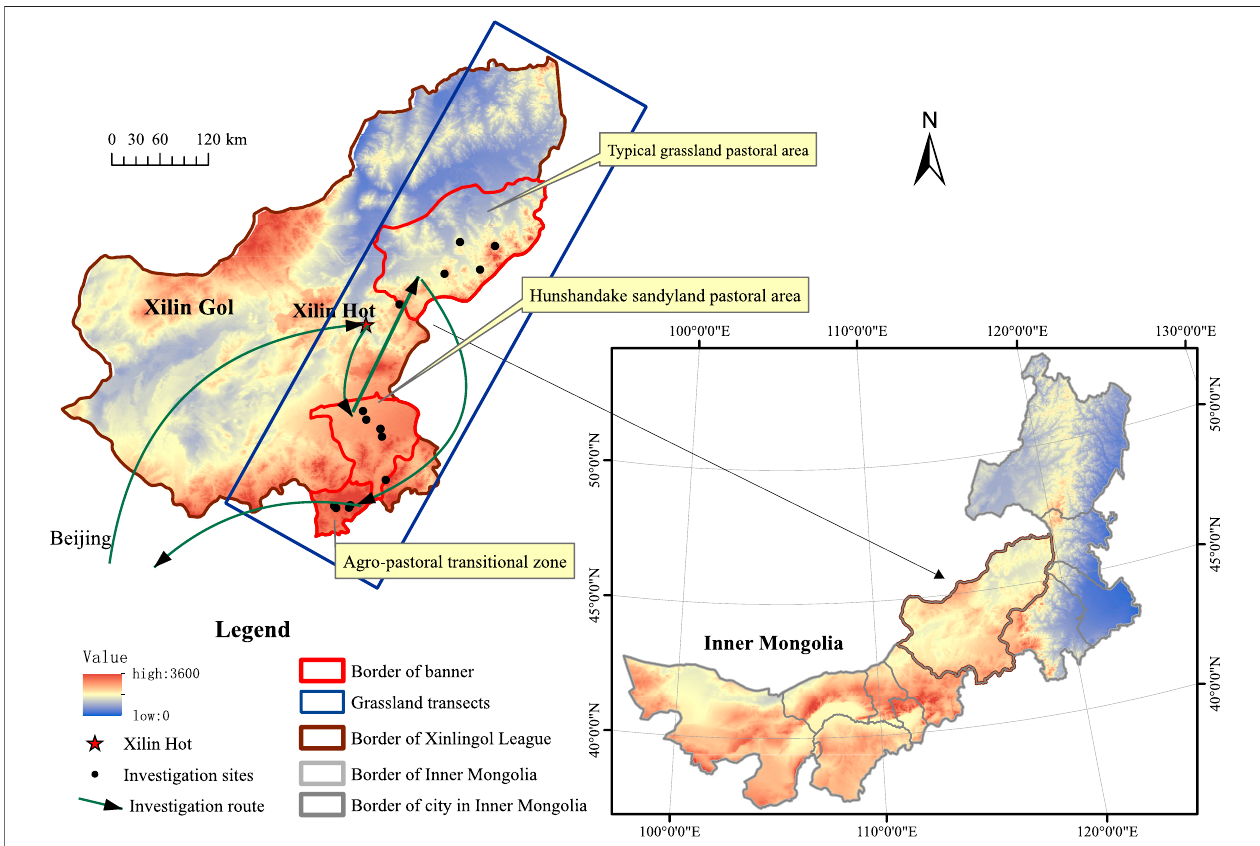
FIGURE 1 | Study areas and investigated sites. Data source: The data center for Resource and Environment Data Platform of CAS (http://www.resdc.cn), and Global Positioning System (GPS) locations of household questionnaire surveys.